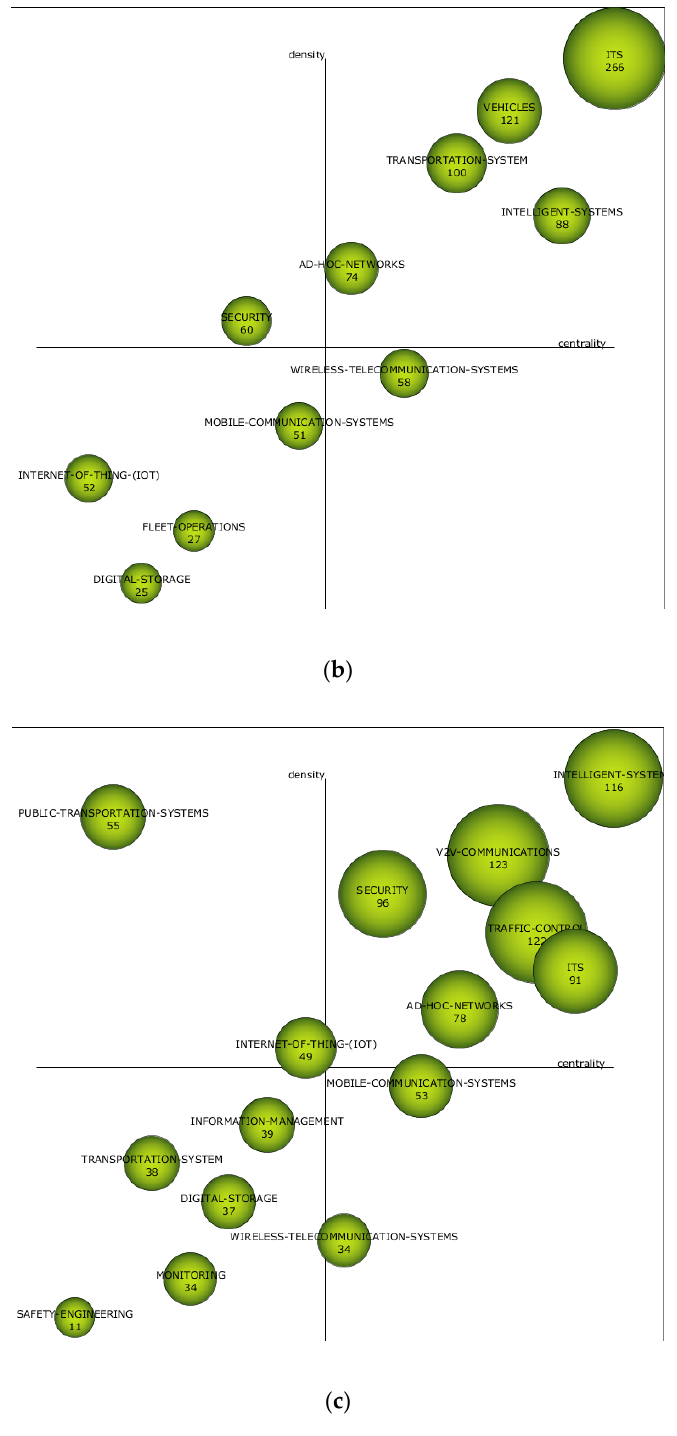
Figure 1. Strategic diagrams based on the number of documents published: ( a ) 2014–2015 time period; ( b ) 2016–2017 time period; ( c ) 2018–2020 time period.